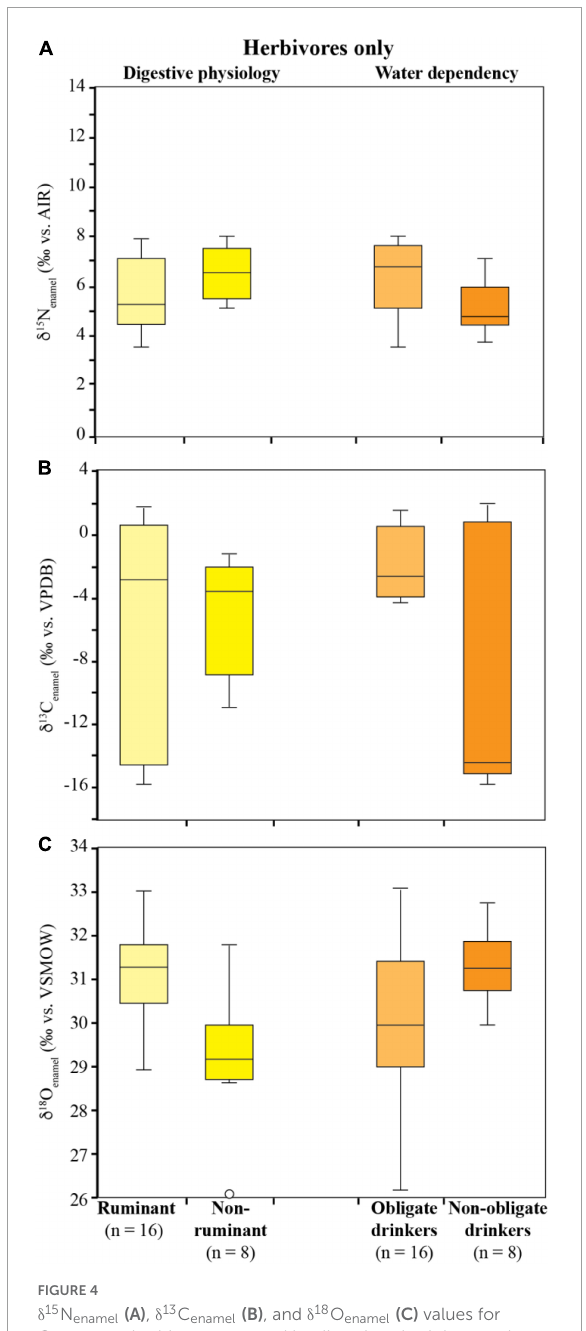
FIGURE4 δ 15 N δ 13 C δ 18 O enamel (A) , enamel (B) , and enamel (C) values for Gorongosa herbivores grouped by digestive physiology and water dependency. Boxplots show the interquartile range, with the median indicated by solid lines and outliers by open circles. Water dependency after Hamilton (1986), Bothma (2005), Wilson and Mittermeier (2009), and Hempson et al. (2015);